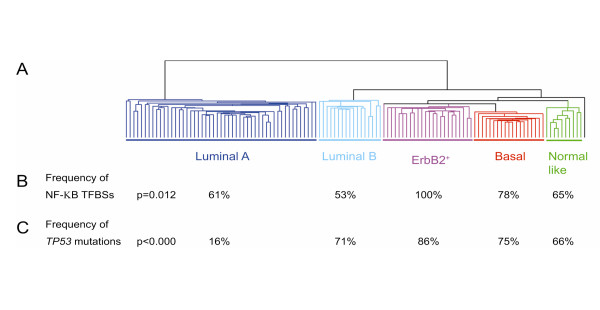
Subtypes with relevance to NF-κB binding sites and TP53 mutations.A. The five subtypes shown by hierarchical clustering using the “intrinsic” gene set. Dendrogram shows the clustering of the tumors into five subgroups. Branches are color-coded. B. Frequency of NF-κB binding sites in the 5 subgroups; and C. Frequency of TP53 mutations.